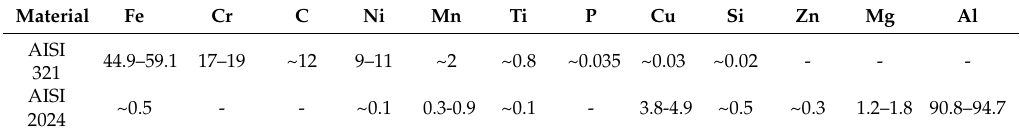
Table 1. The chemical composition of AISI 321 steel and AISI 2024 alloy, %.